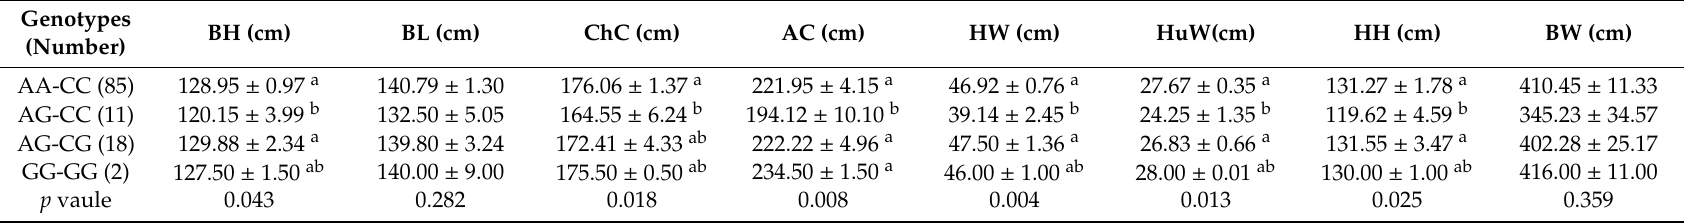
Table 7. Association analysis of combined genotypes in RET with body measurement in Nanyang